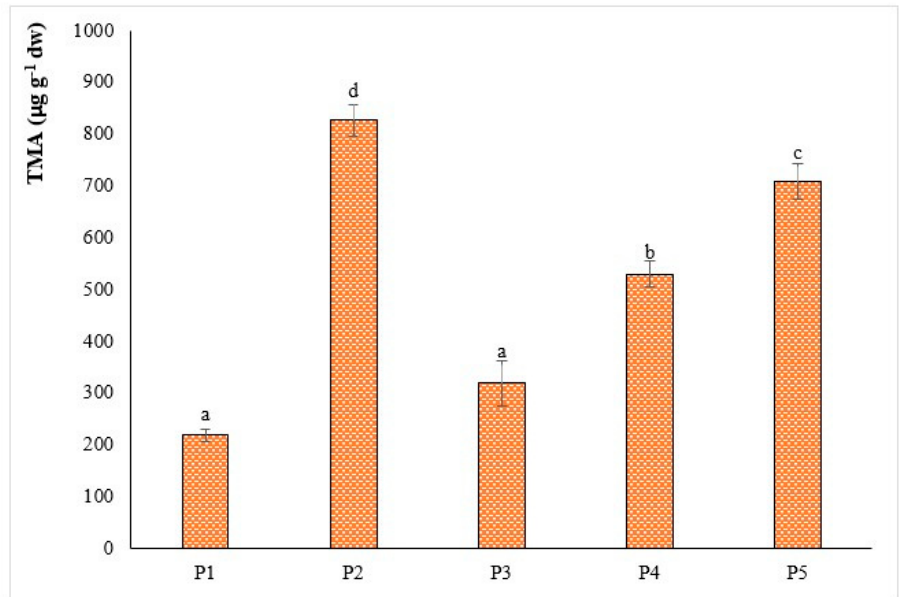
Figure 3. Total content ( μ g g − 1 ) of monomeric anthocyanins of different A. unedo fruit extracts (mean ± SD). Different letters indicate significant differences in the mean ( p < 0.05). TMA: total monomeric anthocyanin.